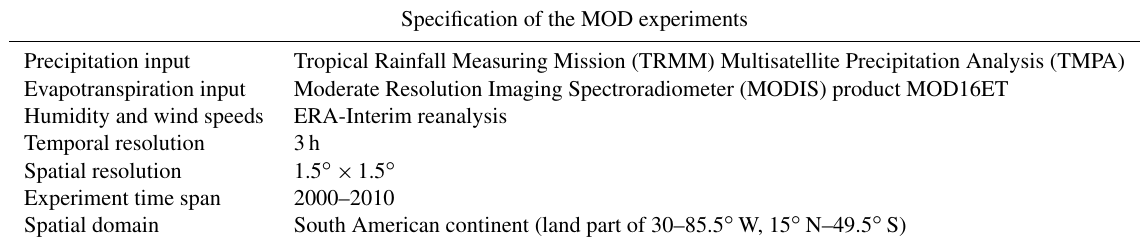
Table 1. The specification of the MOD experiments which were used in our analysis to trace moisture. Specification of the MOD